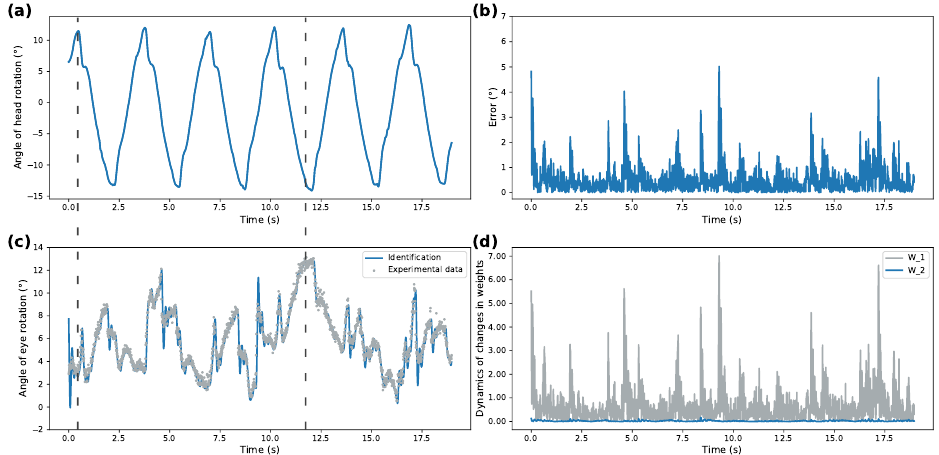
Figure 3. Identification with Izhikevich activation function for high-frequency rotations: ( a )—recorded head rotation; ( b )—identification error; ( c )—recorded data and identification results comparison; ( d )—evolution of weights.